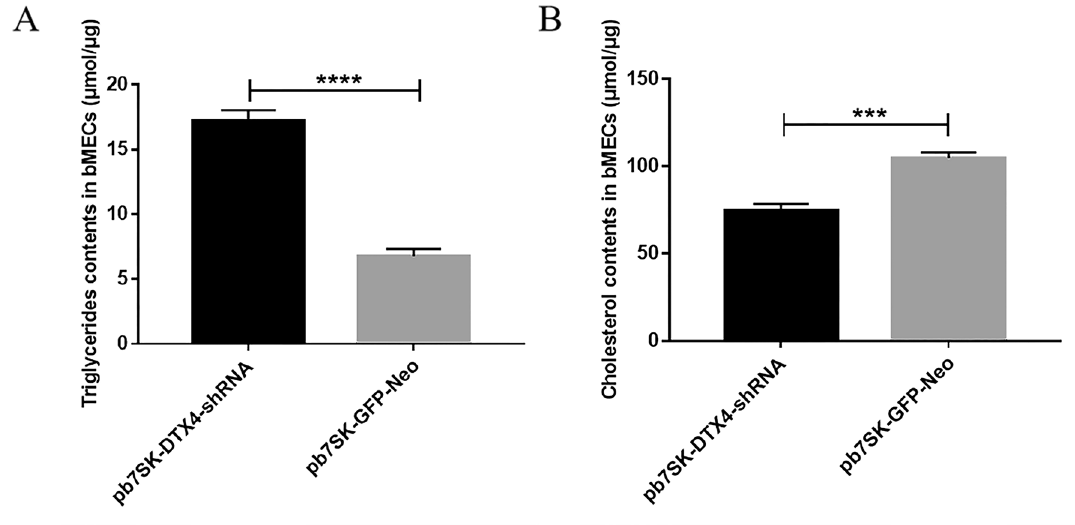
Figure 9. Detection of the TGs and CHOL contents of bMECs after the transfection of pb7SK- DTX4 -shRNA or